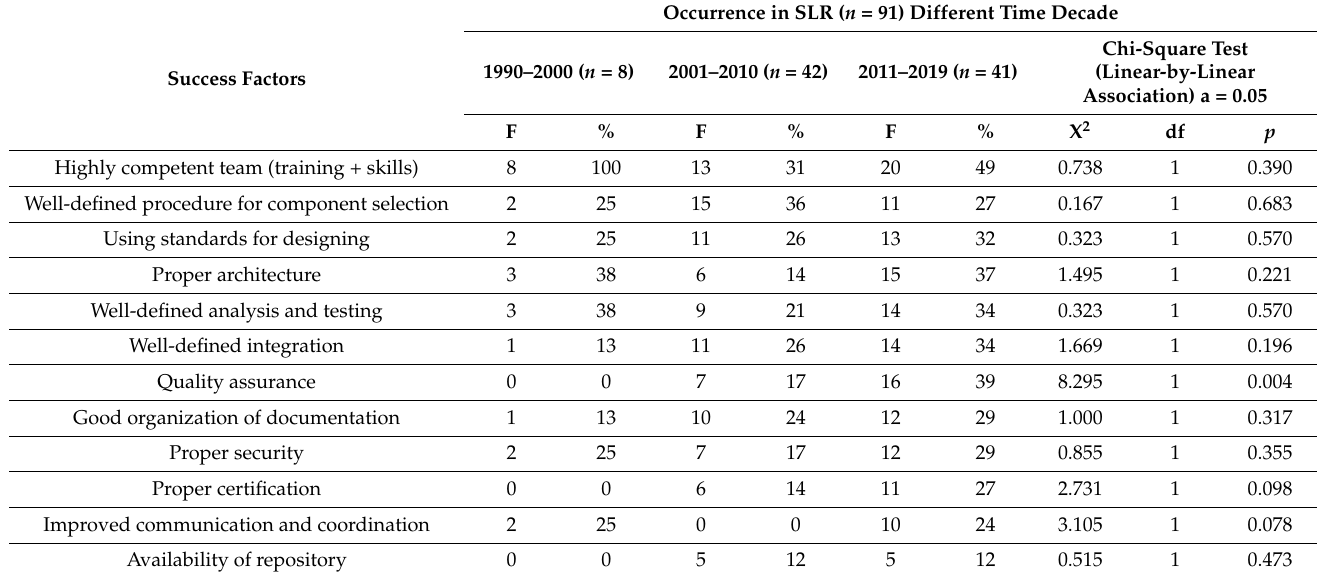
Table 3. List of identified success factors through SLR in two different decades.